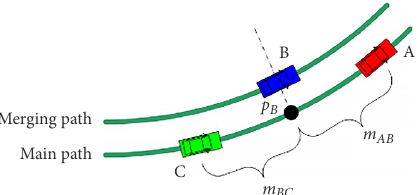
Figure 3. Example of synchronous